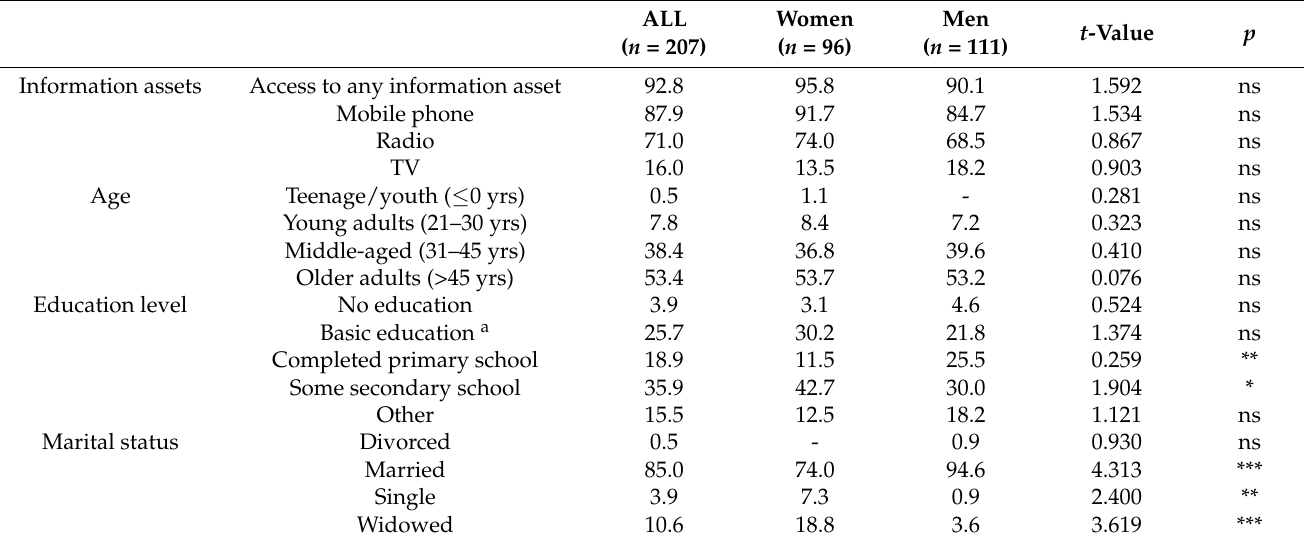
Table 3. Socio-demographic characteristics of farmers who interacted with experts (% of